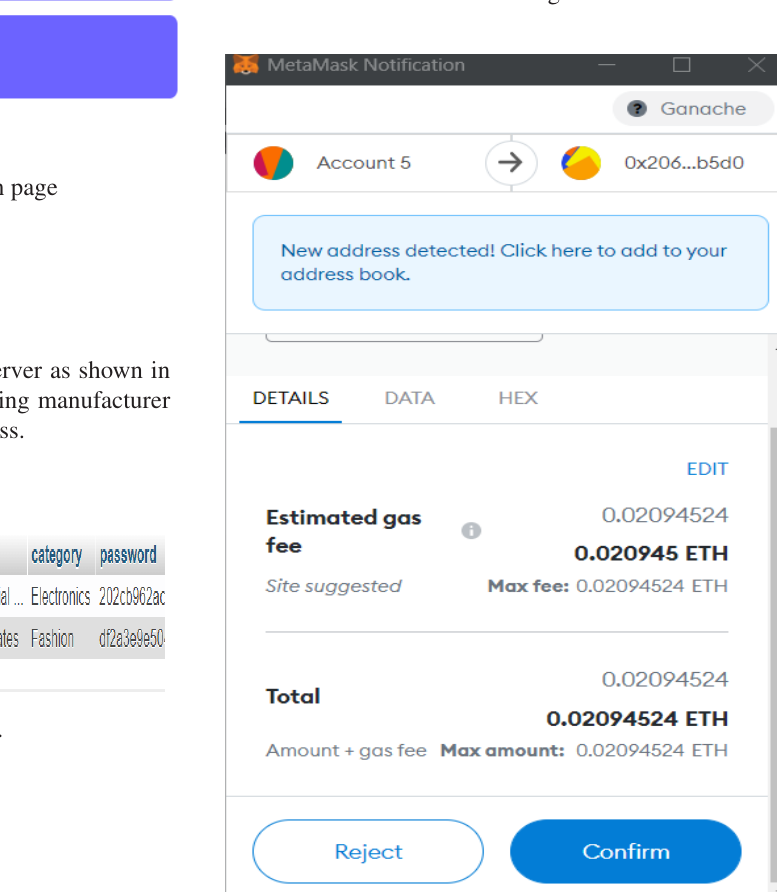
A metamask confirmation popup is displayed which asks for the confirmation as in Figure 11.